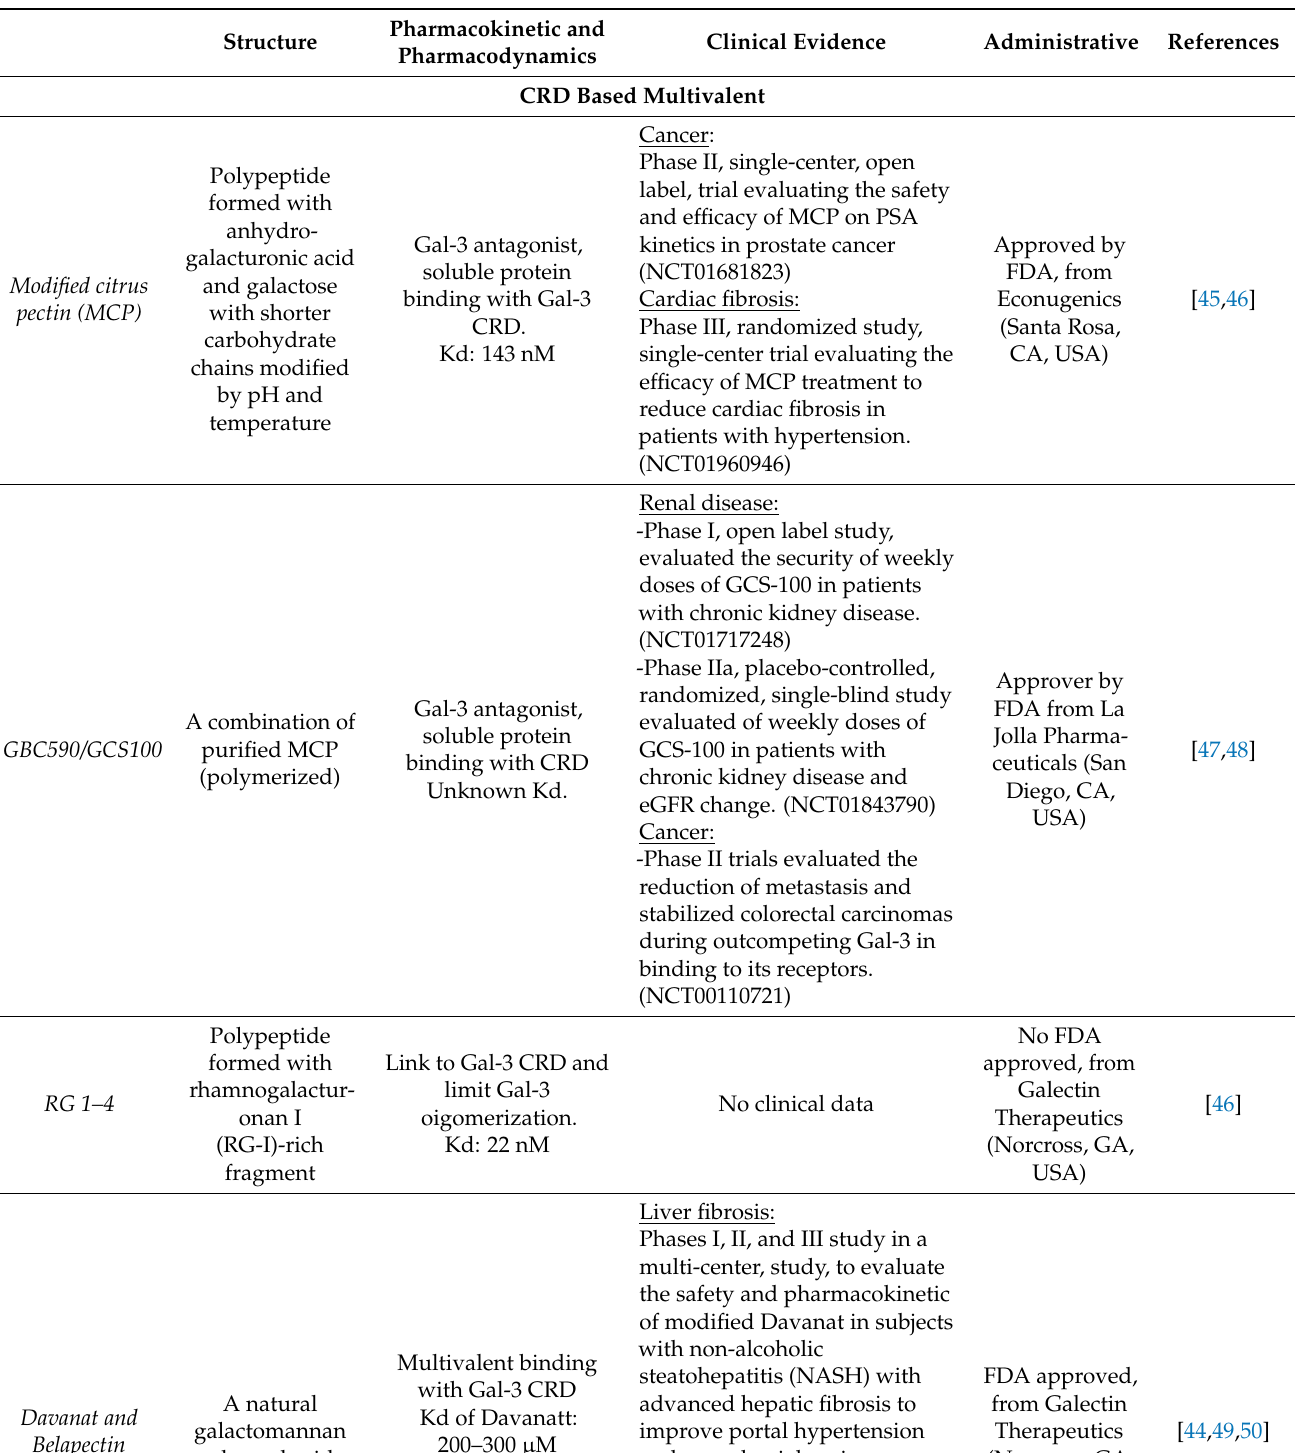
Table 1. Inhibitors of